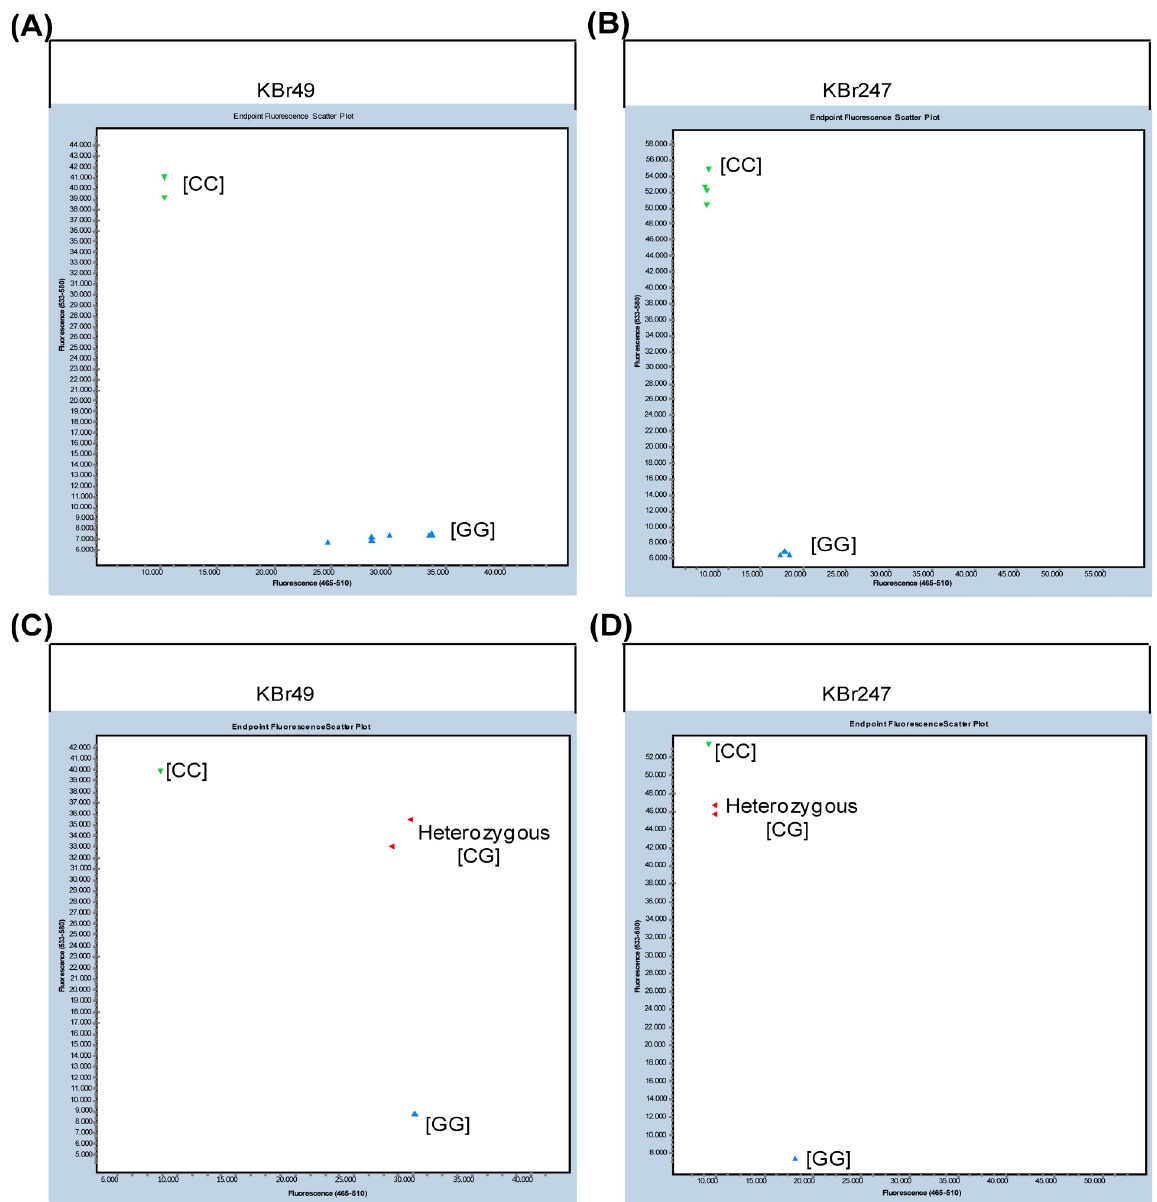
Fig 2. KASP graphs of two different polymorphic SNP types. Co-dominant (A) and dominant (B) KASP marker screened against the four sequenced Chinese cabbage lines (each with two replicates). Co-dominant (C) and dominant (D) KASP marker validated with two homozygous and two heterozygous